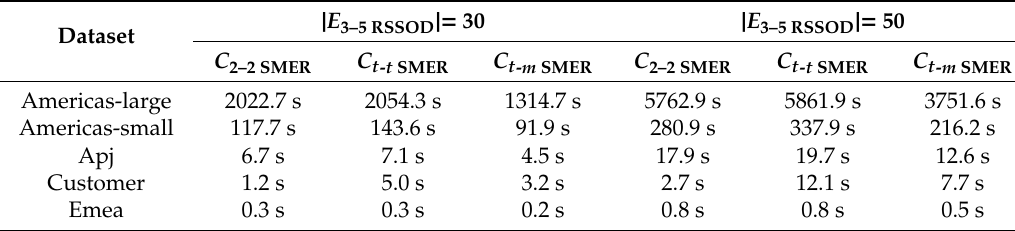
Table 13. Execution time with 3–5 RSSOD.